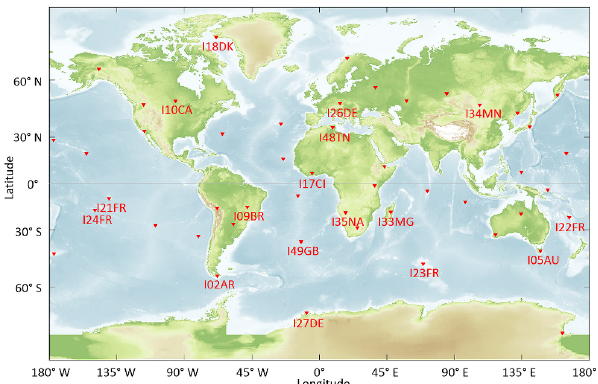
Figure 1. Station map of the IMS infrasound network as part of the CTBT verification regime. Each red triangle represents a certified array (November 2017). The stations labelled are the data base for the study which is subject of this